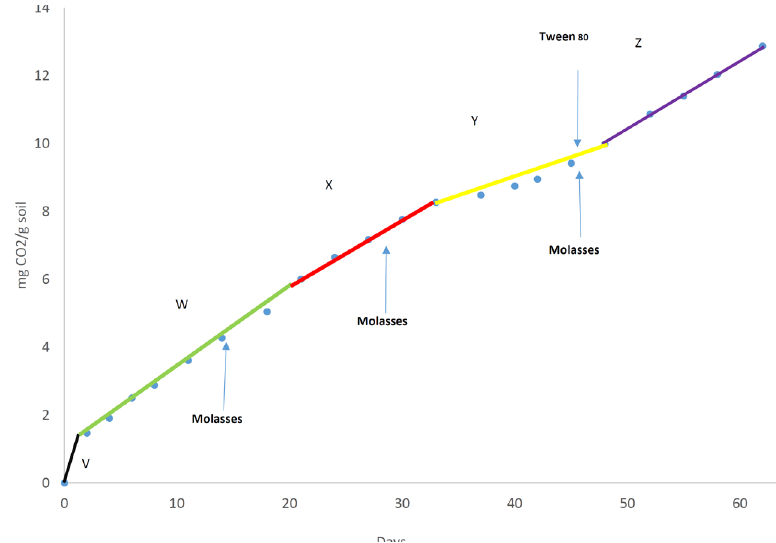
Figure 5. Production of carbon dioxide vs